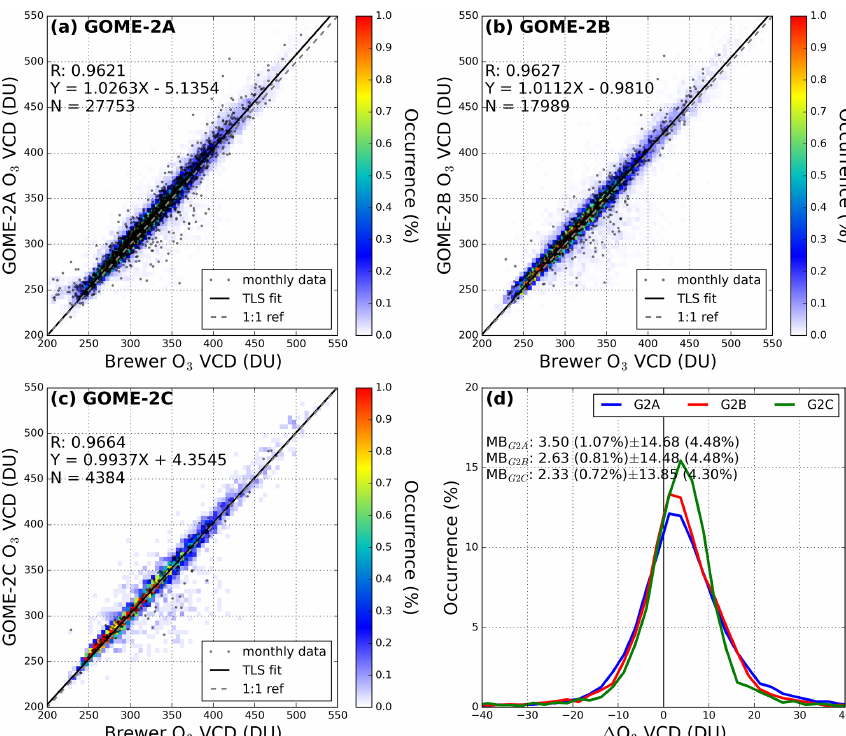
Figure 12. Comparison of daily and monthly total column O 3 measured by the ground-based Brewer instruments to (a) GOME-2A, (b) GOME-2B, and (c) GOME-2C. Histograms of the differences in total column O 3 between GOME-2 and Brewer observations are shown in panel (d) . Co-located daily and monthly averaged data are used in the comparison. Total least-squares regression is based on daily data.